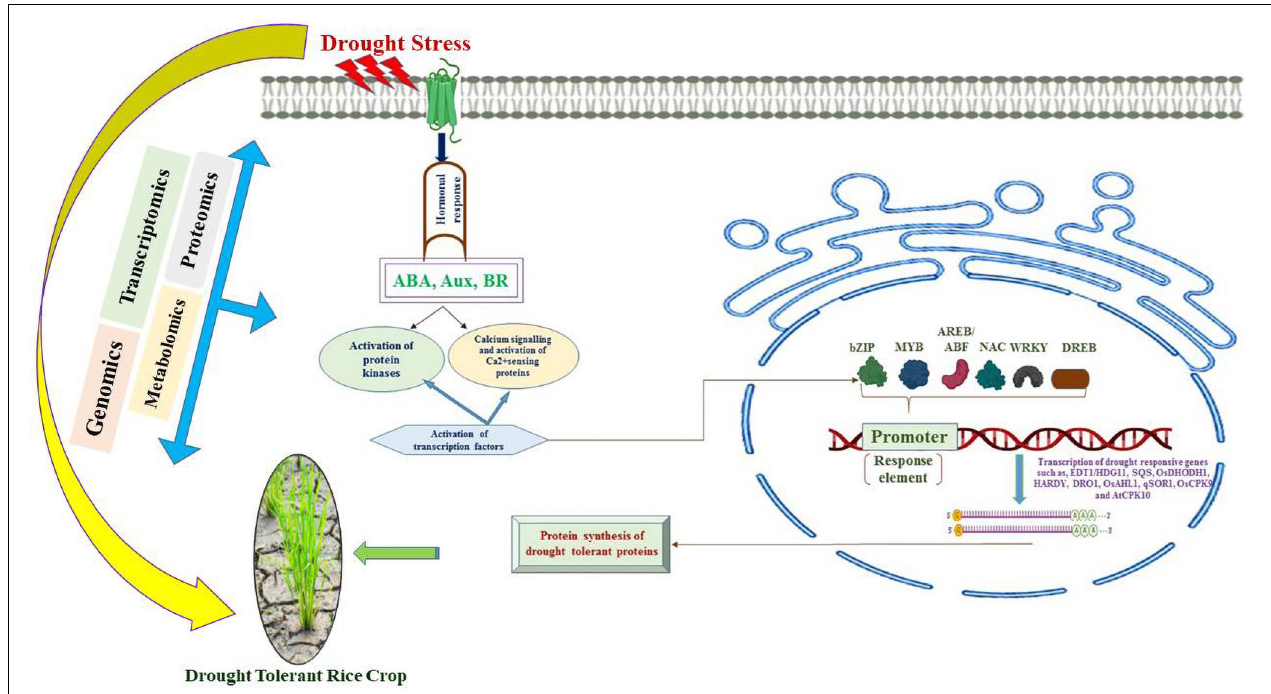
FIGURE 4 | Signaling cascades activated due to drought stress that are involved in the expression of drought tolerance induced